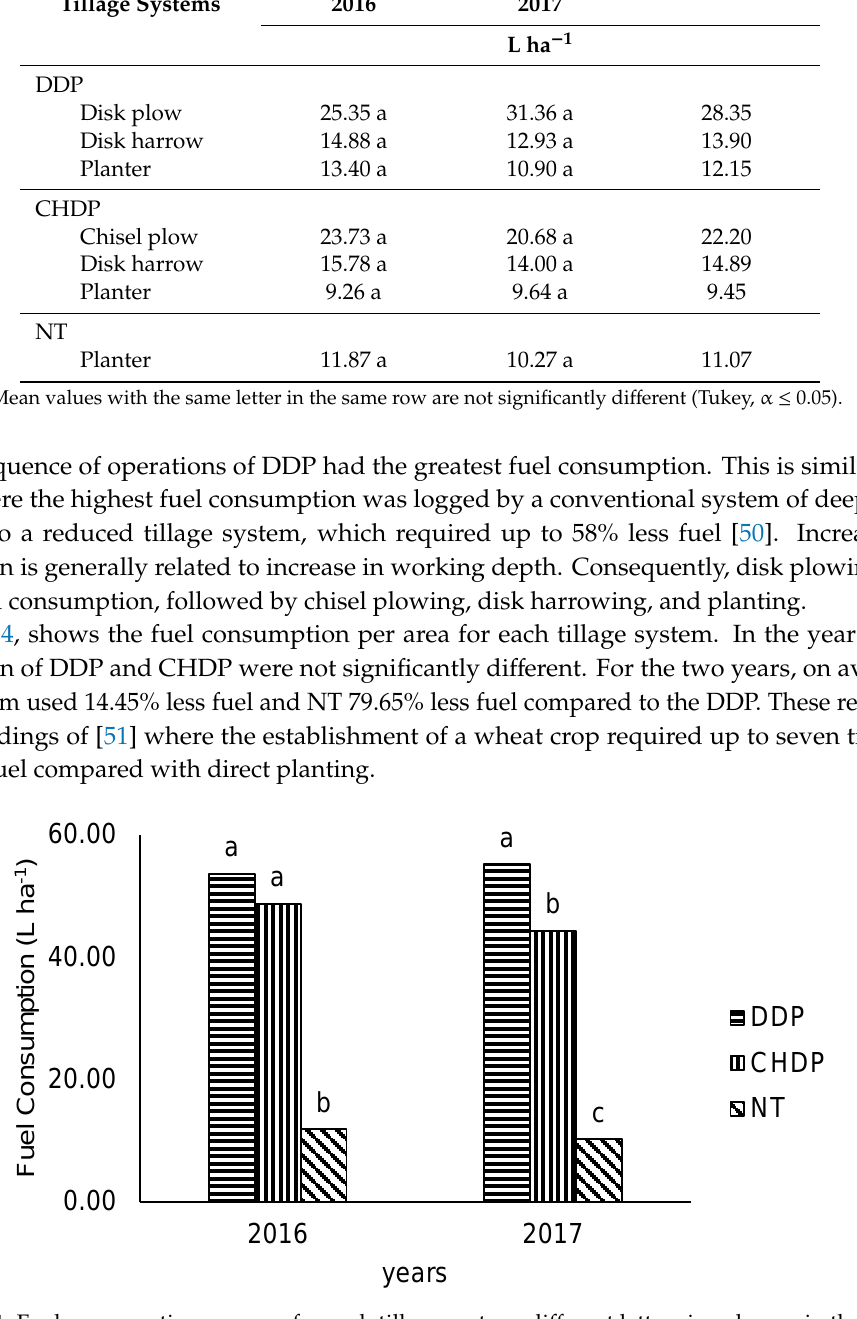
Table 9. Fuel consumption per worked area for each operation in the tillage systems. Tillage Systems